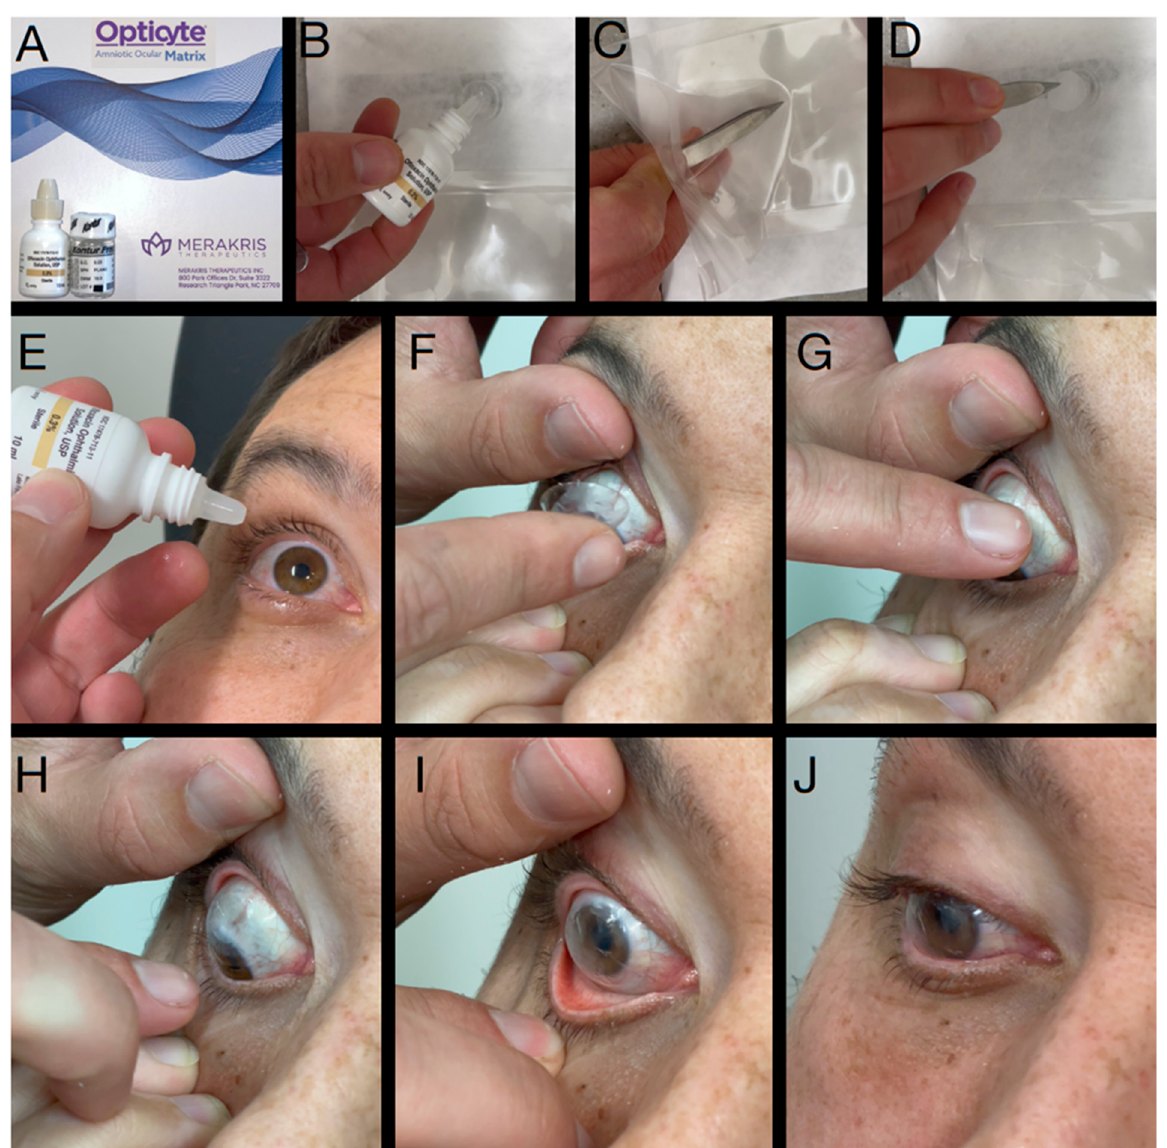
Figure 7. Speculum-Free Insertion of Amniotic Membrane Graft Under Kontur—Through use of a Kontur large diameter contact lens, an antibiotic drop, and an amniotic graft ( A ), a self-retaining amniotic membrane graft without a retaining ring can be created. A drop of antibiotic is placed inside the Kontur ( B ), and then the non-hydrated amniotic membrane is grasped with a pair of jeweler forceps ( C ). The amniotic membrane is placed with one edge touching the antibiotic fluid in the Kontur and the amniotic membrane sequentially adheres to the contact lens through hydrostatic attraction, similar to the application of a screen protector ( D ). Next an antibiotic drop is instilled in the eye ( E ) and then the patient is told to look down and pull down on their lower lid ( F ). The clinician then pulls up on the lower lid and places the Kontur with adhered AMG ( G ). Once on the eye ( H ) the patient is told to look down thereby centering the lens and AMG over the cornea ( I ). Next the patient and clinician release their fingers from the lids ( J ).